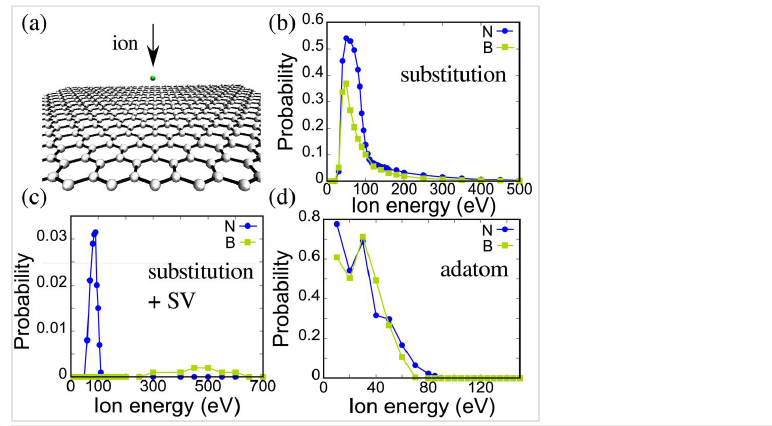
Simulations of N and B implantation into graphene (Åhlgren et al. 2011). (a) A schematic illustration of the simulation geometry. (b-d) Probabilities of resulting configurations as functions of the ion energy, characterized from the outcomes of the MD simulations. (Figure courtesy of Jani Kotakoski / University of